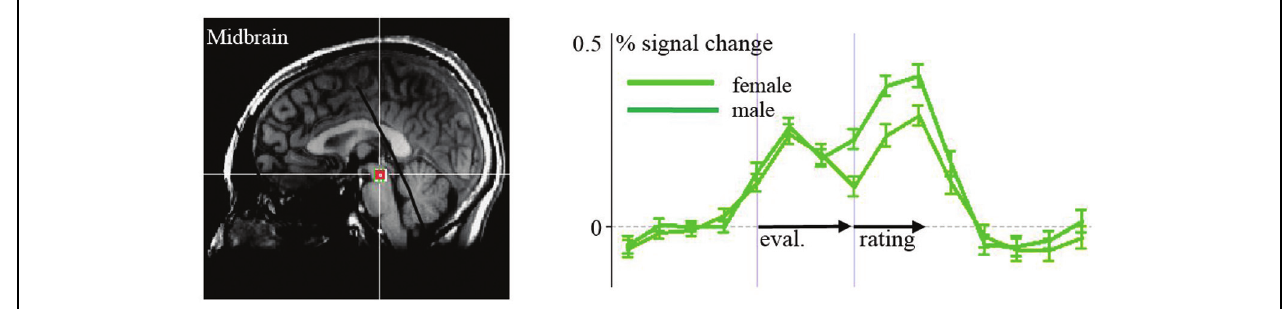
FIGURE 5 | ROI-Analyses of females vs. males: activation in the midbrain to healthy food items is stronger in females than in